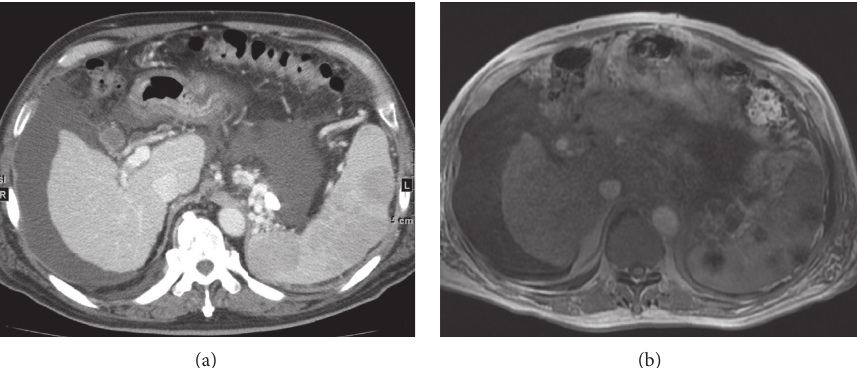
Figure 3: (a) CT with contrast revealed multiple small low-attenuation areas in the spleen. (b) MRI of the spleen revealed multiple low- intensity areas on T1-weighted